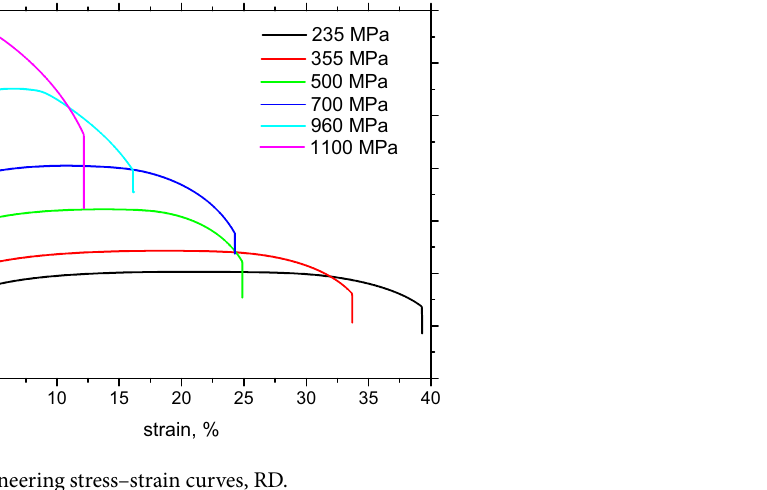
Figure 2. Engineering stress–strain curves,